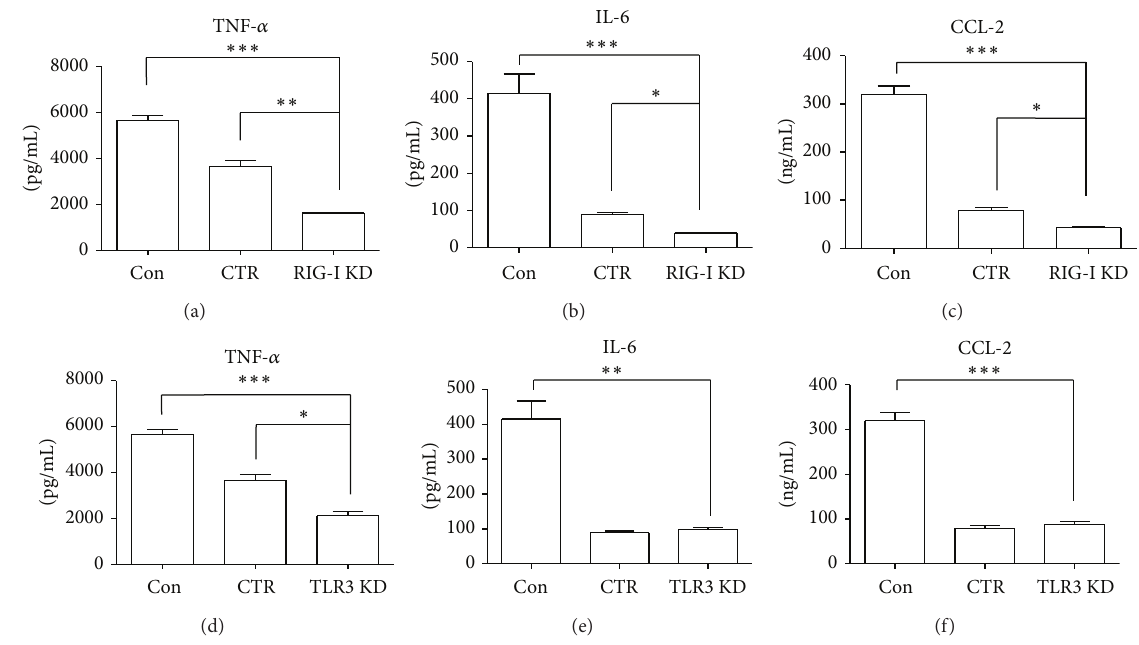
Figure 8: Proinflammatory cytokines and chemokines induced by JEV in TLR3 and RIG-I knockdown BV-2 cells. BV-2 cells were transfected with RIG-I shRNA (RIG-I KD), TLR3 shRNA (TLR3 KD), or negative control shRNA (CTR) and then infected with JEV at an MOI of 1. The production of TNF- 𝛼 (a, d), IL-6 (b, e), and CCL-2 (c, f) was measured with ELISA. Error bars represent the standard deviation of results from three independent assays ( ∗ 𝑃 < 0.05 ; ∗∗ 𝑃 < 0.01 ; ∗∗∗ 𝑃 < 0.001